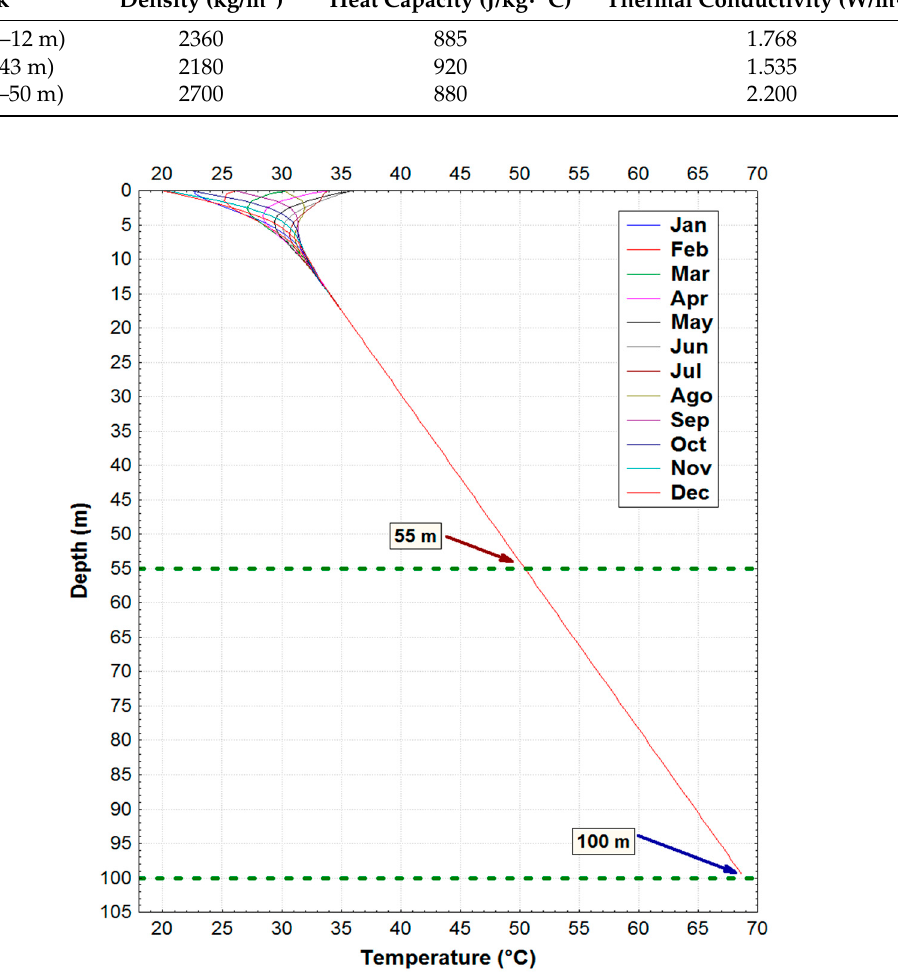
Figure 6. Thermal profile of the ground temperature variation for 100 m of depth for each month of the year 2017 (from La Reforma caldera).